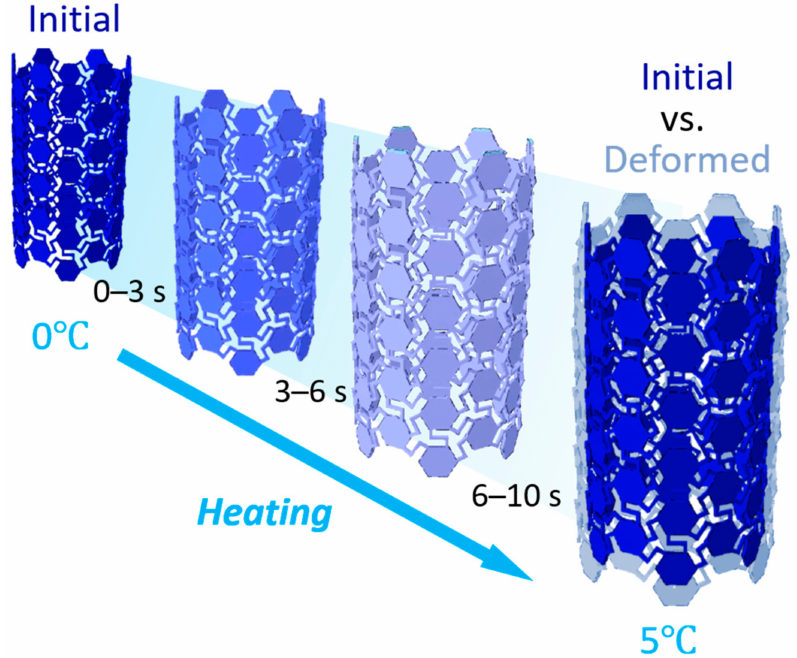
Figure 4. Thermal expansion process of the chiral tubes triggered by temperature